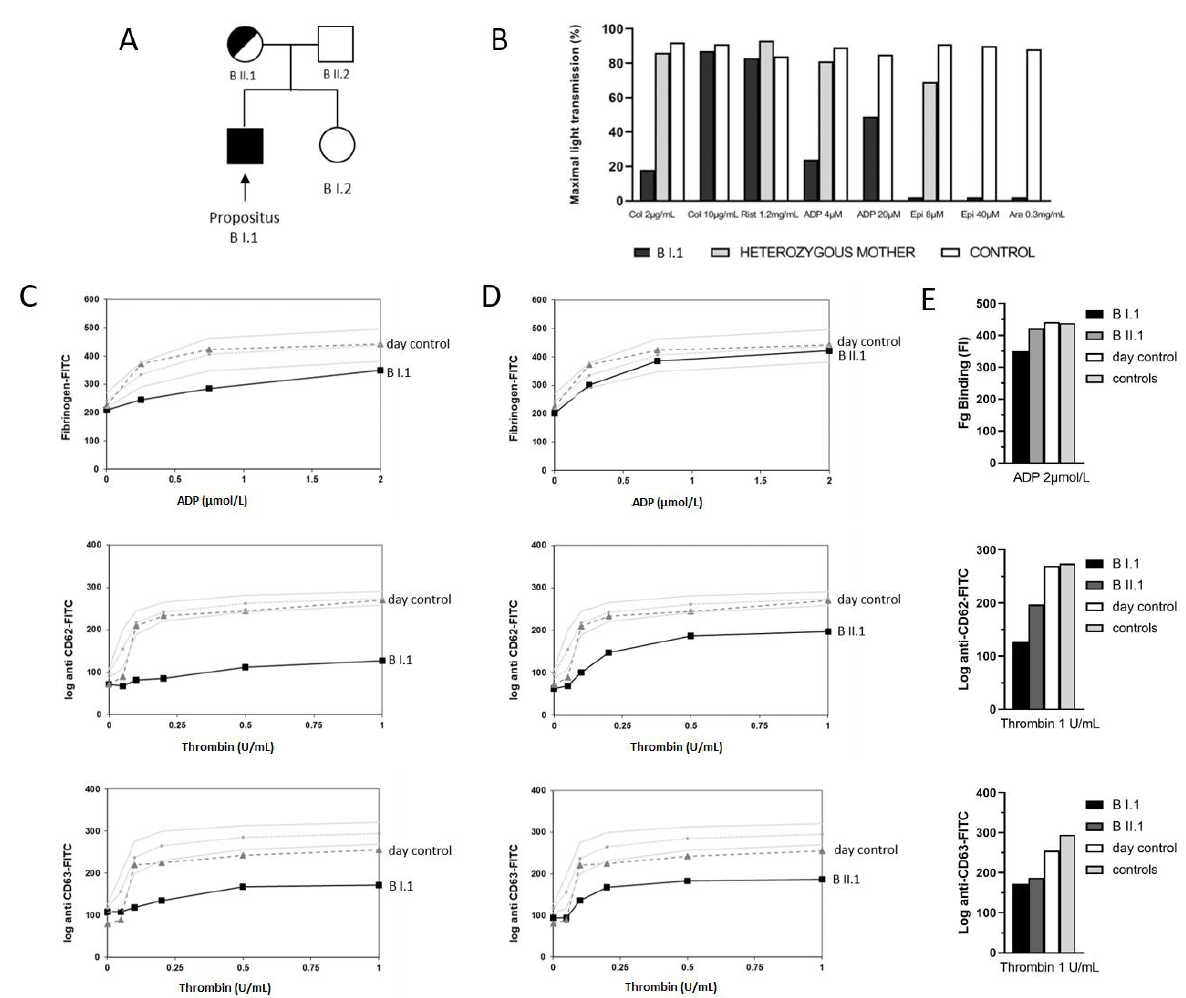
Figure 1. Family tree and platelet phenotyping in the German pedigree B. ( A ) Genetic pedigree of family B. Solid black symbols represent affected family member carrying the hemizygous GATA1 p.H289Y variant; black–white circles represent heterozygous female carrier of the variant. ( B ) LTA for propositus (B I.1) and his heterozygous mother (B II.1): low-dose collagen, arachidonic acid, and epinephrine failed to induce platelet aggregation, whereas platelet aggregation was reduced in response to ADP in B I.1. The heterozygous mother showed mildly reduced aggregation after stimulation with epinephrine. Ristocetin-induced agglutination was normal for both patients. Flow cytometry for propositus ( C ) and for the mother ( D ) as line diagram: only hemizygous propositus displayed reduced fibrinogen binding ( upper panel); propositus and his mother showed reduced CD62 expression, more severe in the propositus (B I.1) ( middle panel), and reduced CD63 expres- sion ( lower panel). Data of patients and controls (day control and 20 independent measurements from 10 controls as mean ± standard error of the mean (SEM)). ( E ) Combined histogram: bars corre- spond to fluorescence intensity (FI) values (log) at the highest concentration of the used stimulant.